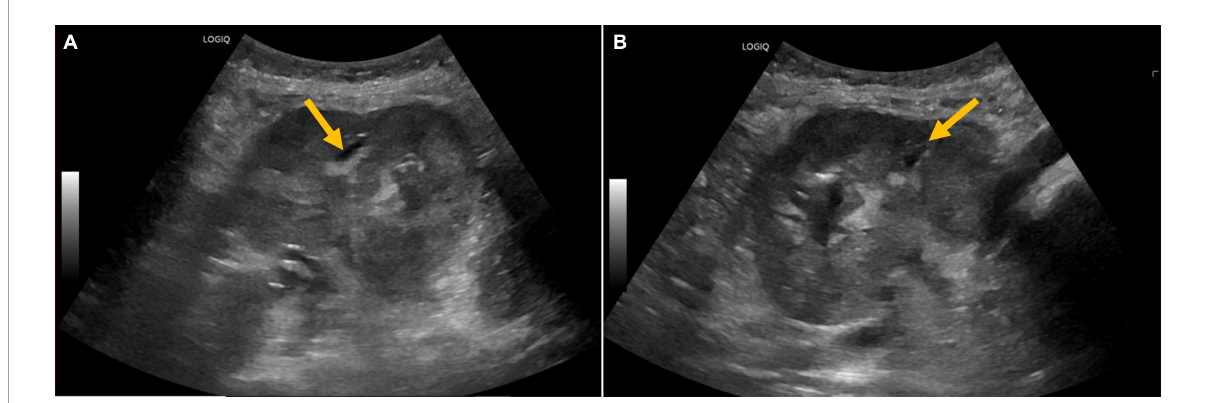
FIGURE1 (A,B) Ultrasound of the kidney allograft with abnormal echogenicity and ill-defined hyperechoic areas with poor acoustic shadowing, raising suspicion of air in the pelvicalyceal